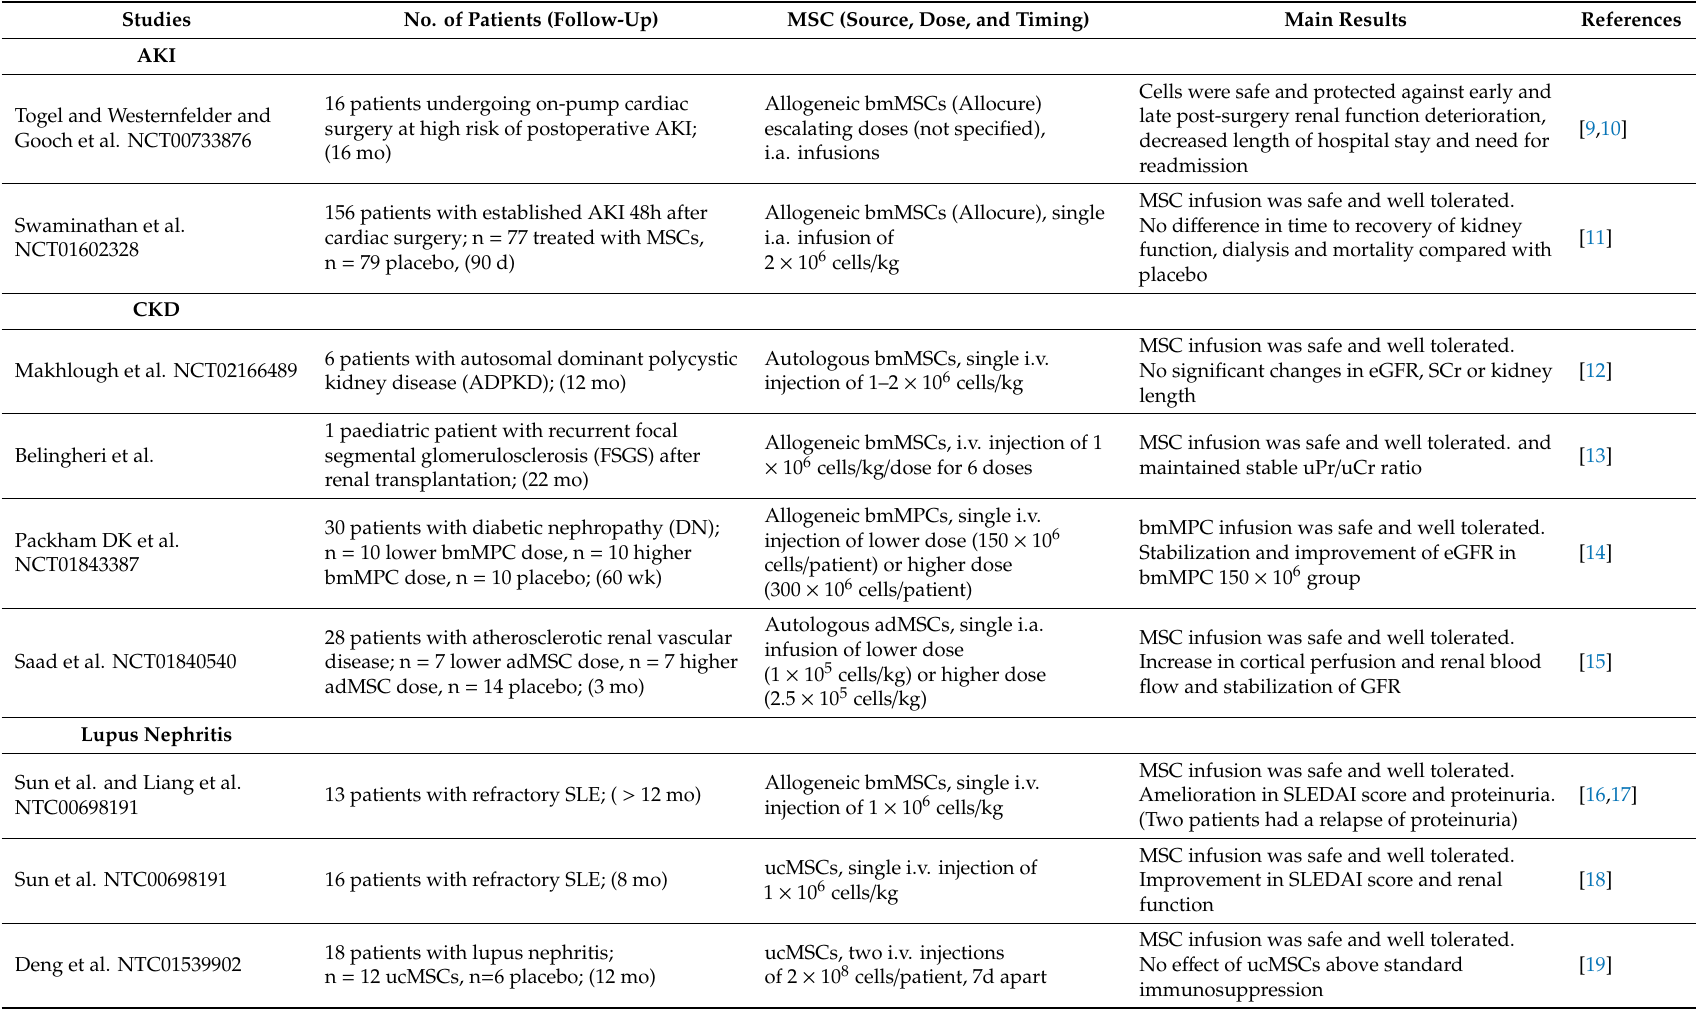
Table 1. Clinical trials with human MSCs in kidney